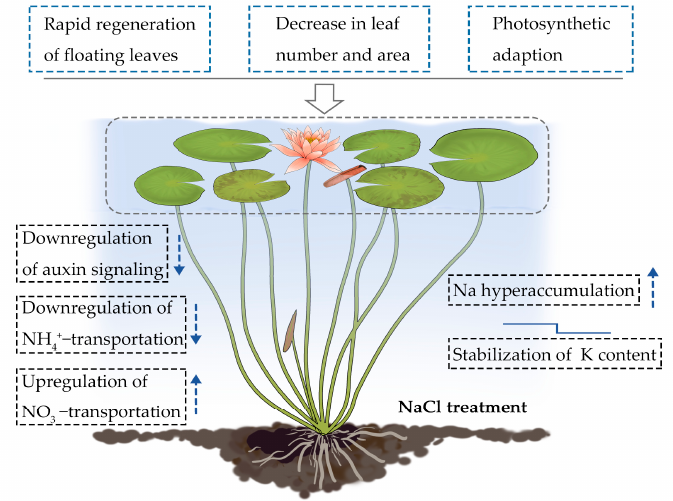
Figure 10. Proposed model for the survival strategies used by the floating leaves and petioles of water lilies under salt stress. The arrow pointing up indicates upregulation of gene expression, and the arrow pointing down indicates downregulation of gene expression under salt stress. The small mark above K content represents minor downregulation followed by homeostasis.